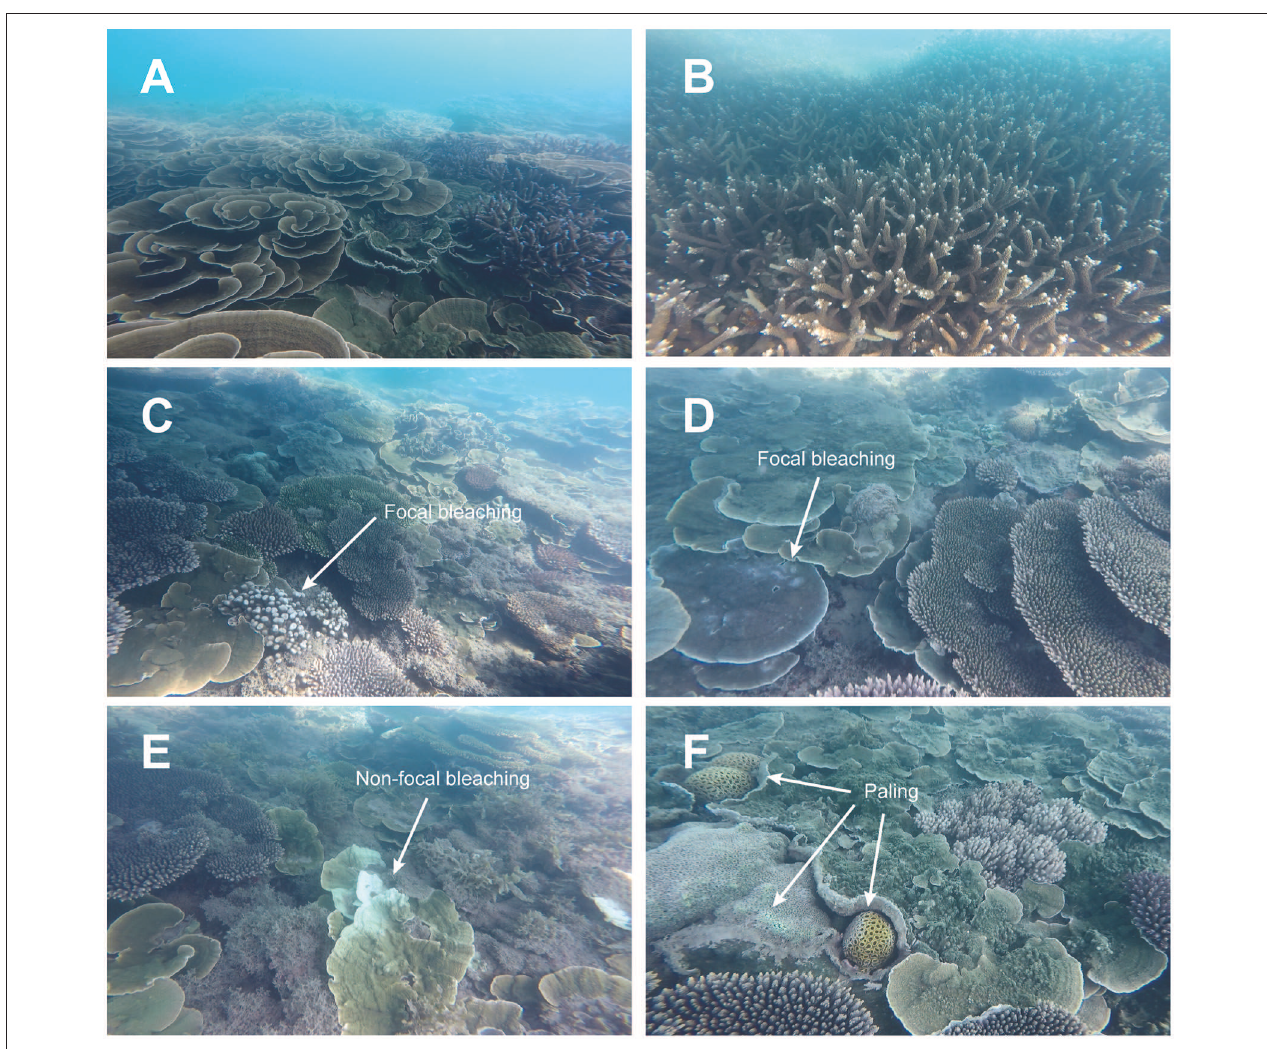
FIGURE 3 | Turbid-zone coral communities of the Paluma Shoals reef complex (PSRC) following the 2016 bleaching event (photos taken at 1–3m water depth during a period of exceptional water clarity). (A,B) Corals exhibit high coral cover of taxa generally considered most susceptible to bleaching (e.g., branching Acropora ). (C,D) Examples of focal bleaching (small multifocal patterns of bleaching with discrete borders to healthy tissue) typically observed on Porites sp. nubbins and Montipora sp. plates. (E) Non-focal bleaching (small diffuse patterns of bleaching on colony surface) affecting part of a Montipora sp. colony. (F) Coral paling (lack of pigmentation) associated with submassive coral